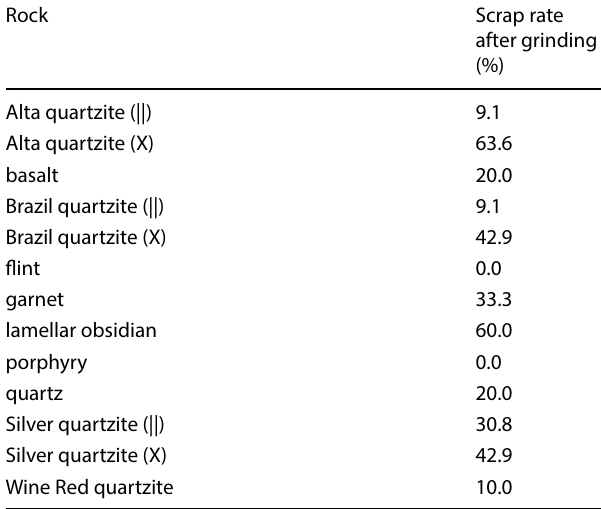
Table 9 Scrap rate after the grinding